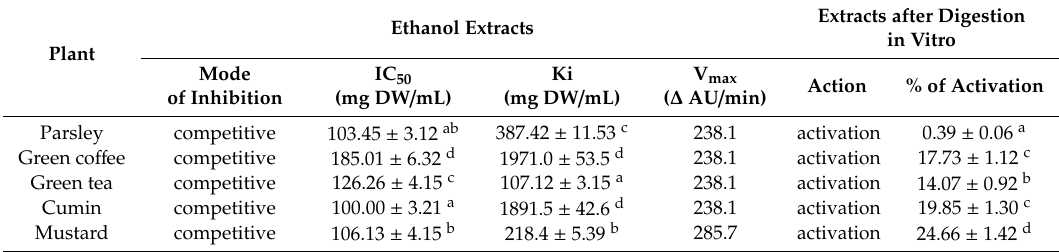
Figure 3. Mode of TPO influence by digested extracts of parsley ( A ), green coffee ( B ), green tea ( C ), cumin ( D ), and mustard ( E ). Table 4. IC 50 value, Ki value, V max value and impact on TPO of ethanol and digested extracts from parsley, cumin, green tea, green co ff ee, and mustard ( n =